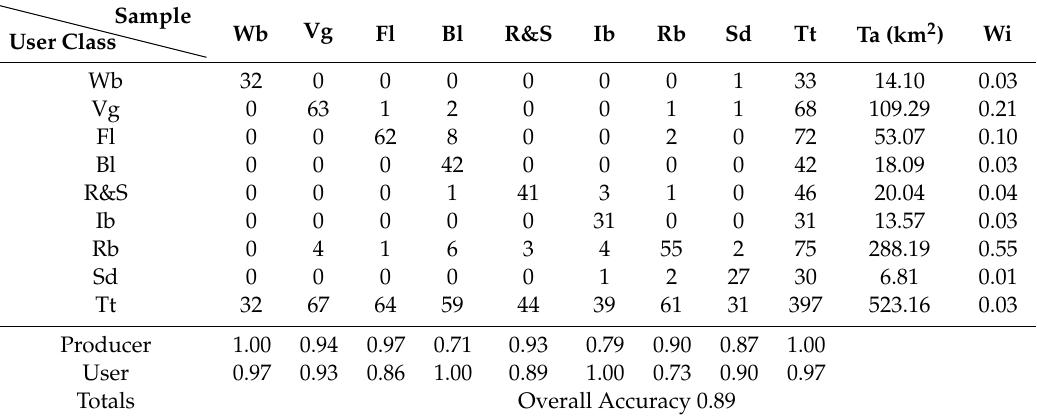
Table 5. Assessment of the second layer of the urban LULC map.